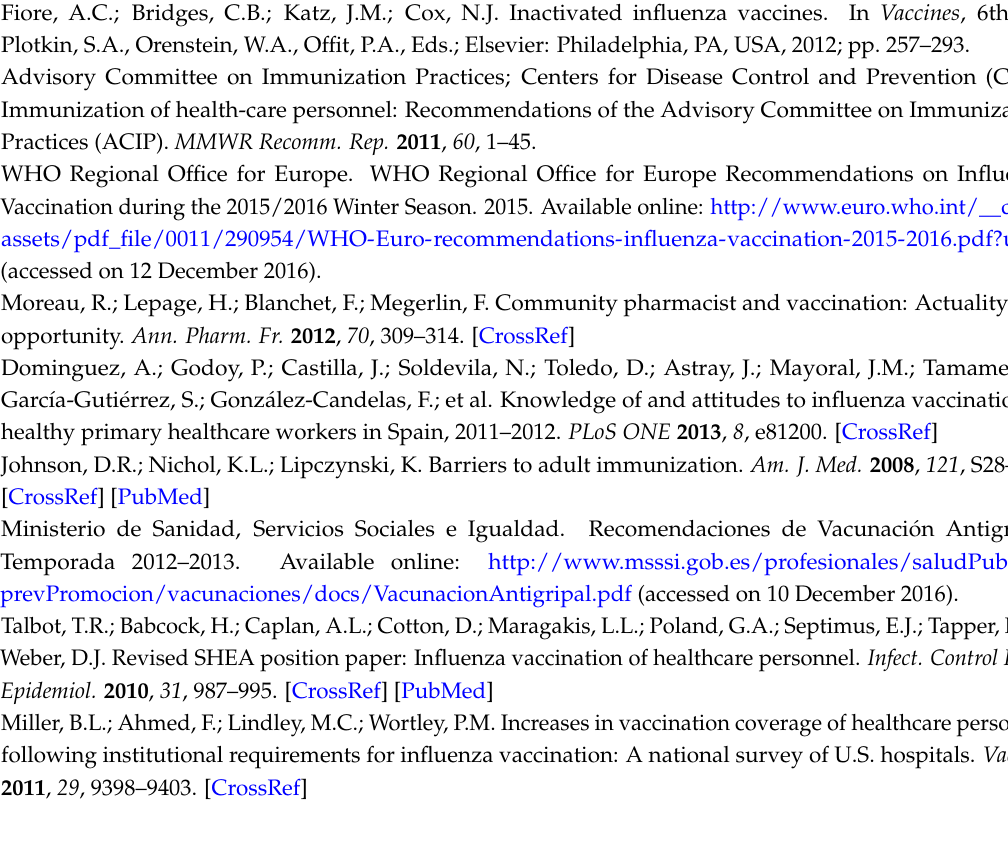
Table S1: Distribution of characteristics of all pharmacists finally